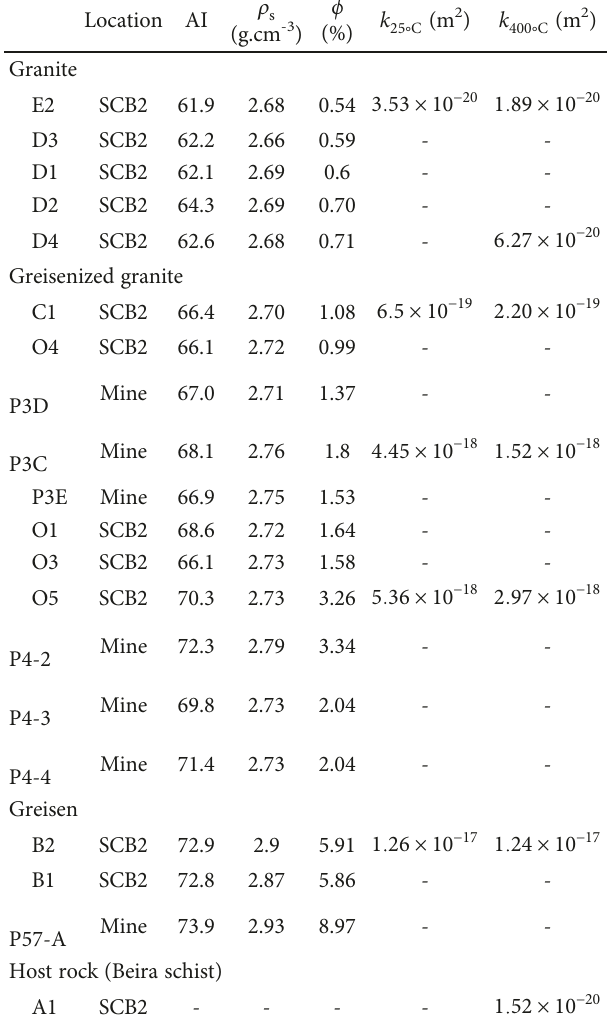
Table 2: Rock petrophysical properties measured in samples of granite, greisenized granite, and greisen from Panasqueira. AI corresponds to the chemical alteration index de fi ned in Section